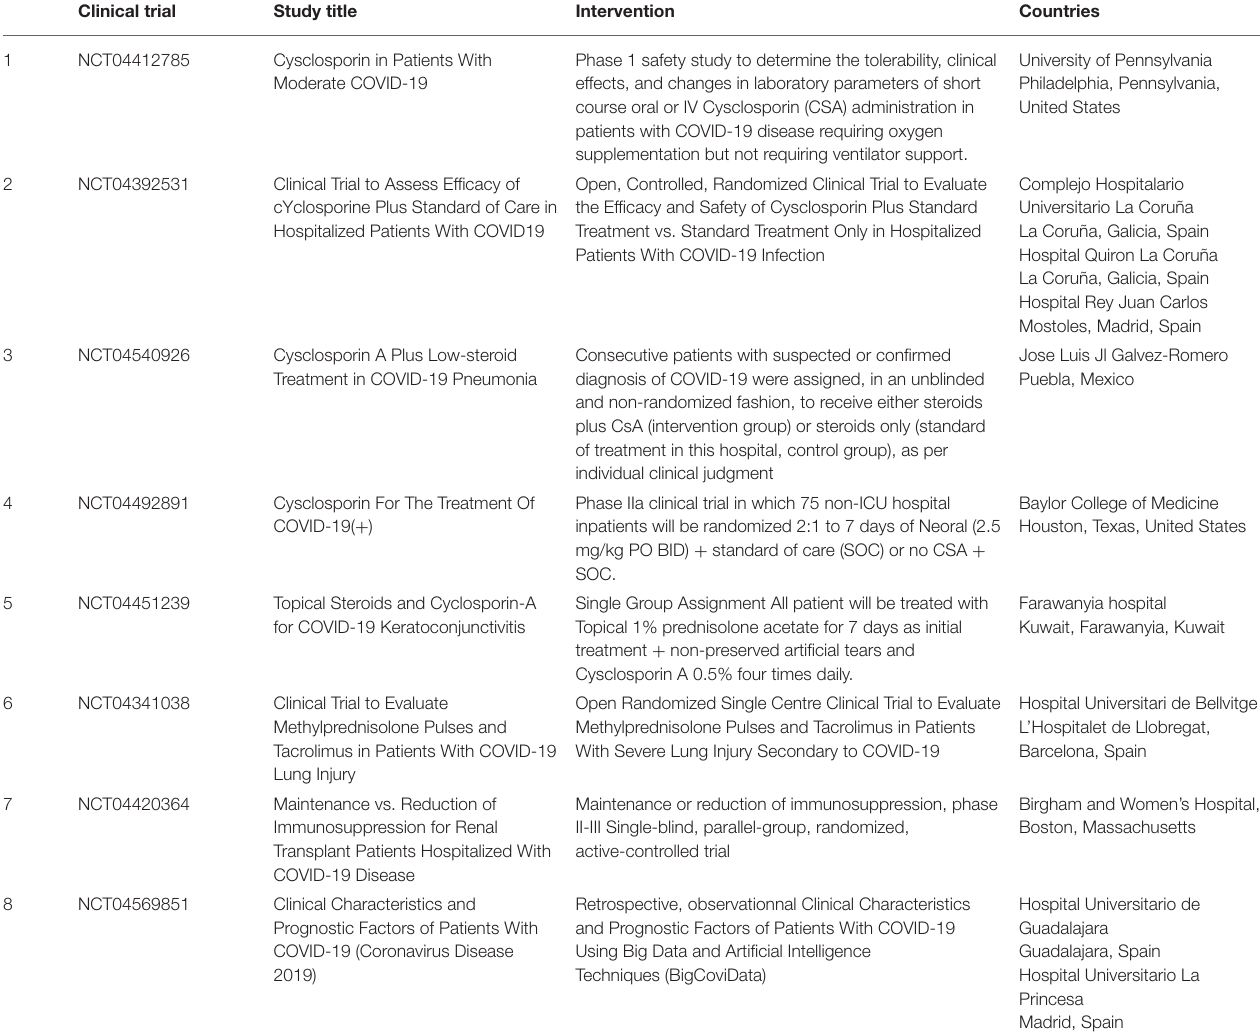
TABLE 4 | FDA approved clinical trial proposing cyclosporine A to treat SARS-CoV-2